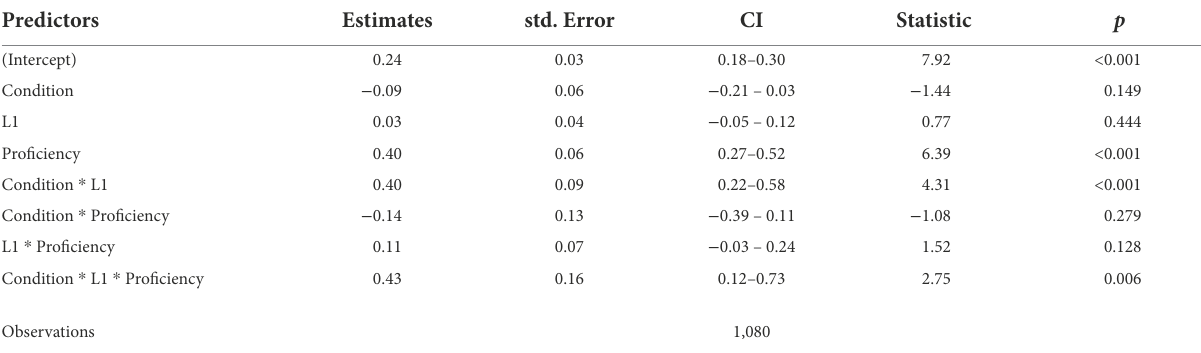
TABLE 5 Summary of the linear mixed-effect models for target responses.